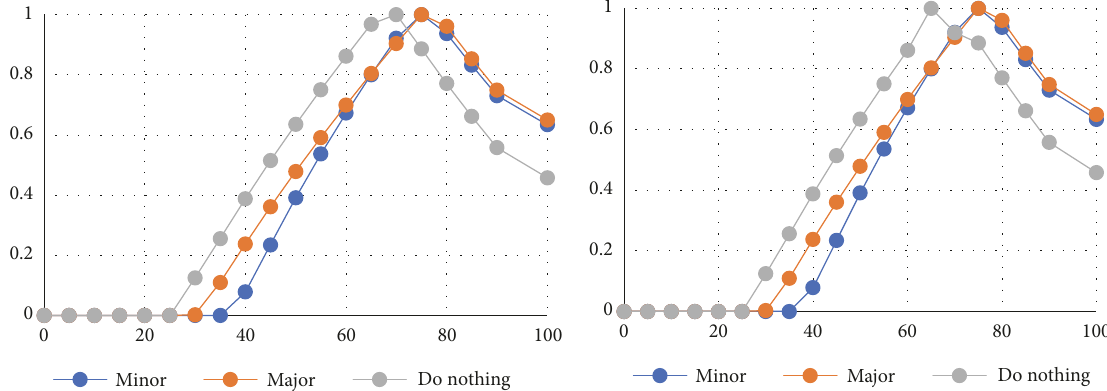
Figure 6: Fuzzy probabilities for no consequences state for (a) safety risk and (b) environmental risk.